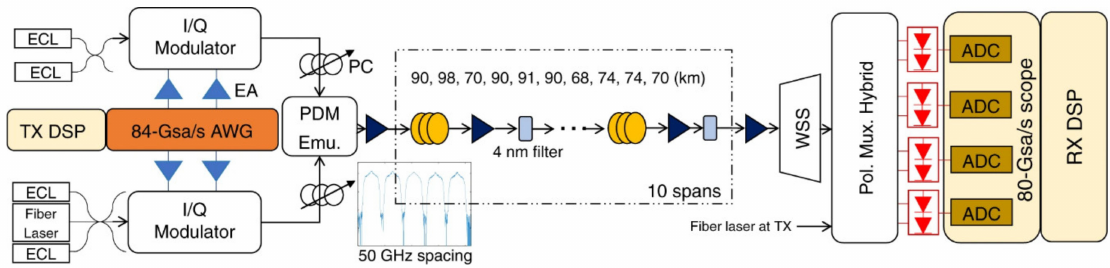
Figure 18. Experiment setup for PDM-WDM